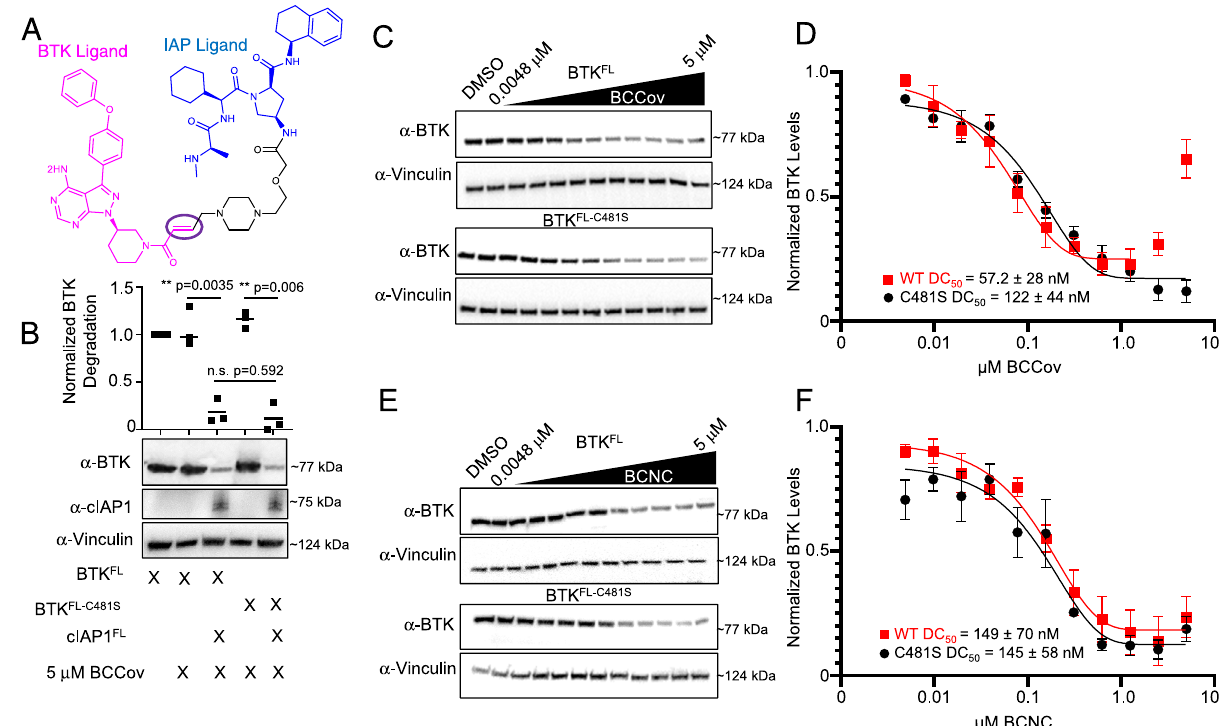
Fig. 1 | DegradationofBTKviacovalent and non-covalent chimeric degraders. A SchematicrepresentationofBCCov.RegionscorrespondingtotheBTKwarhead (magenta), linker (black), and IAP warhead (blue) are indicated. Reactive alkene circledinpurple. B WesternblotoftransientlytransfectedBTK FL ,BTK FL-C481S ,and/or cIAP1 FL with or without 5 µ M BCCov treatment. Degradation of BTK across 3 sepa- rate experiments were quanti fi ed and normalized to untreated BTK FL and plotted asascatterplotaroundthemedian.RepresentativewesternblotsforBCCov( C , D )